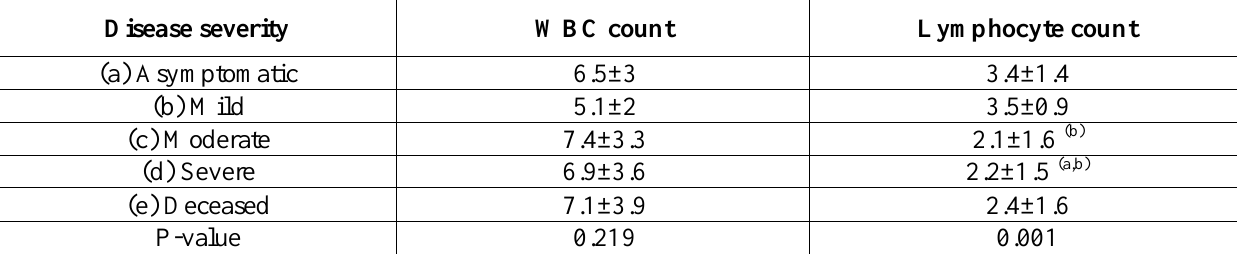
Table 3: White blood cell (WBC) and lymphocyte counts (x10 9 /L) in 100 patients with COVID-19 revealed different severities.